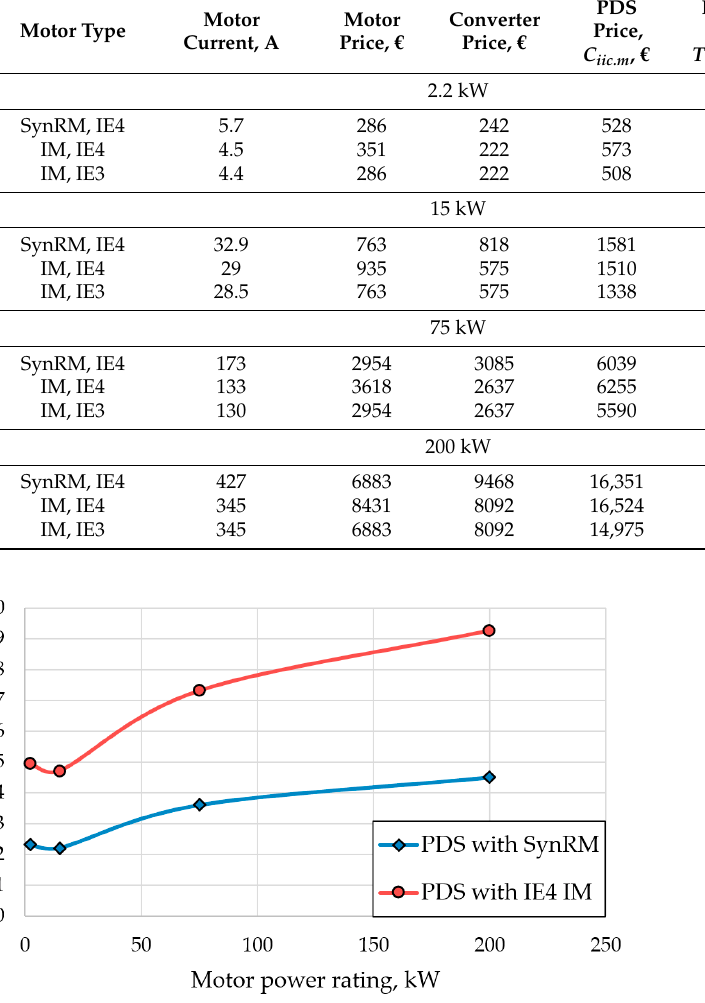
Figure 7. Payback time versus motor power rating.